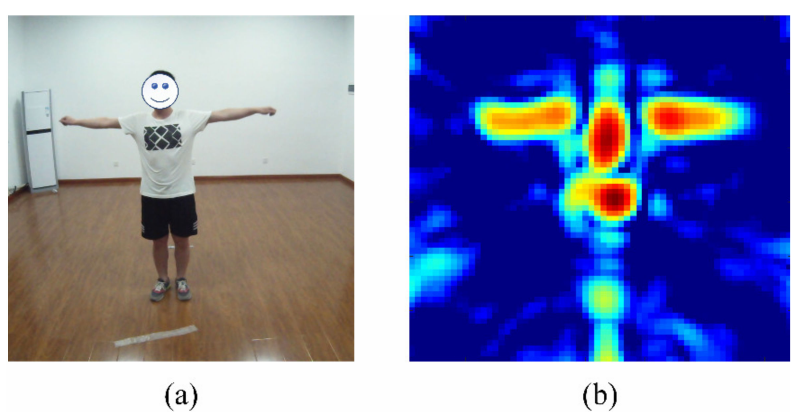
Figure 10. ( a ) Human target; ( b ) Azimuth-height projection image of the 3D radar image.